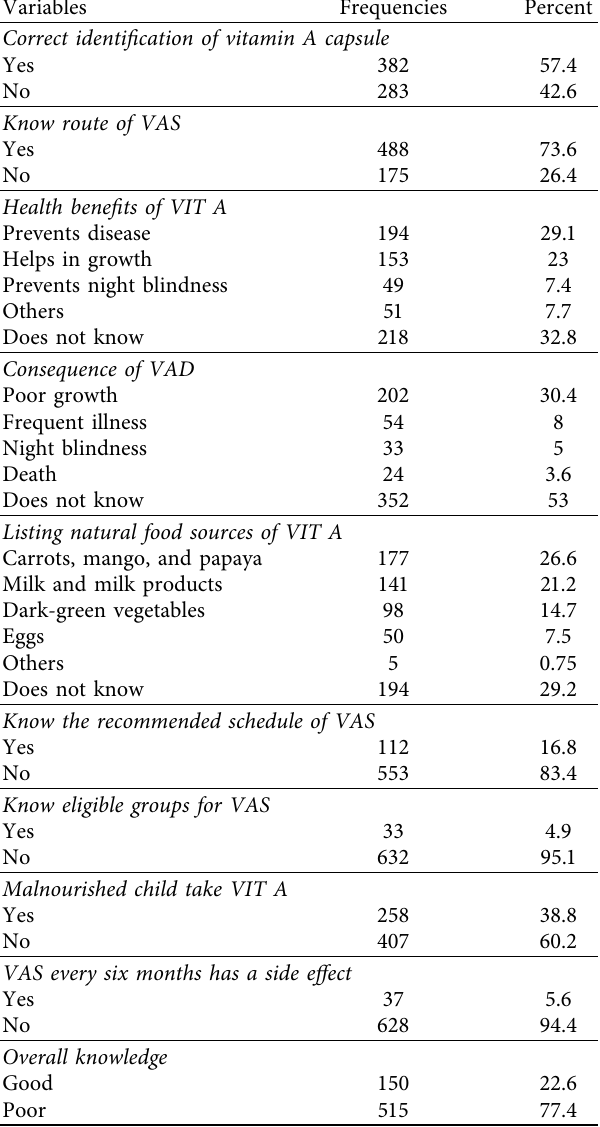
Table 3: Vitamin A-related knowledge of mothers with children 6–59 months among mothers or caregivers in Aleta Chuko woreda, 2019.